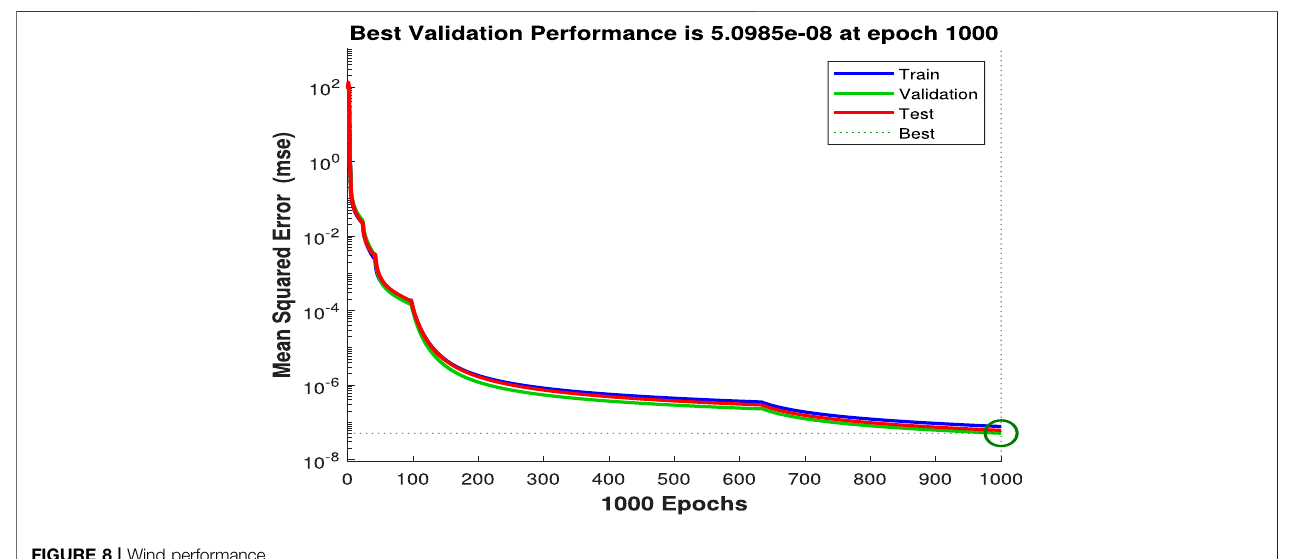
FIGURE 7 | Solar performance.